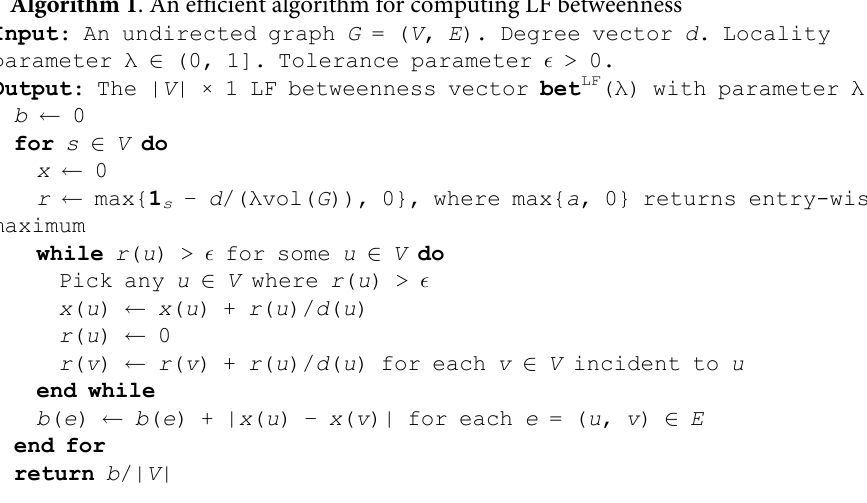
Algorithm 1 . An efficient algorithm for computing LF betweenness